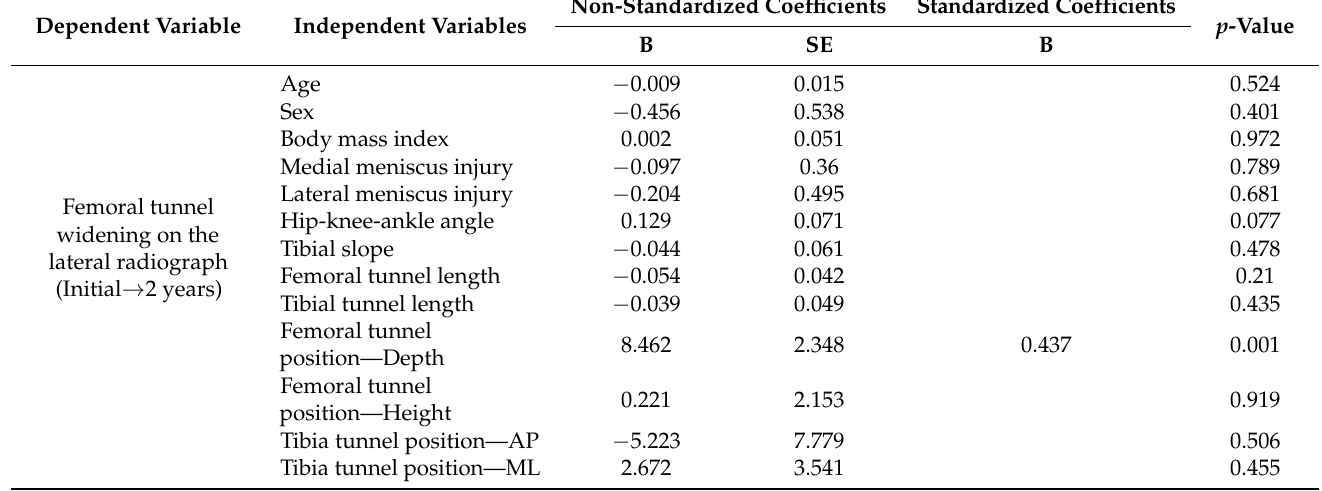
Table 7. Multiple regression analysis of potential predictive factors correlated with the femoral tunnel widening observed on the lateral